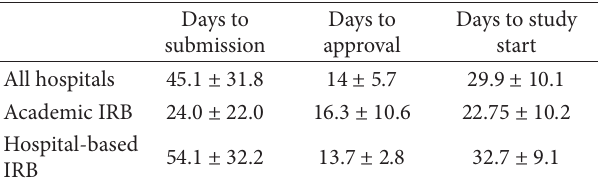
Table 2: Study start-up times (in business